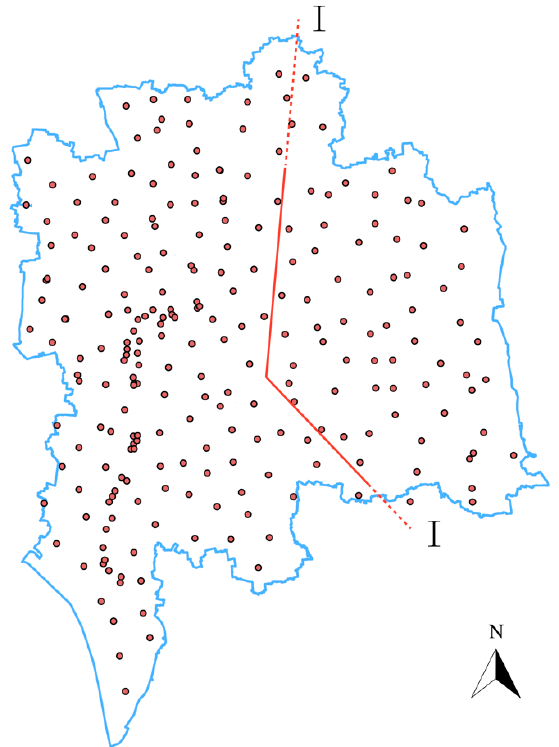
Figure 8. The position of the profile.